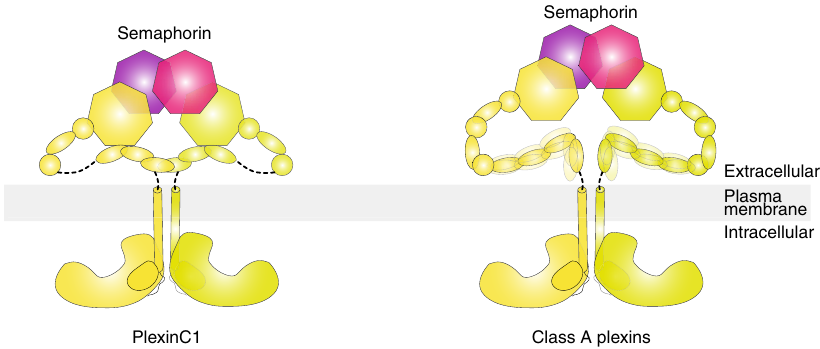
Fig. 6 Cartoon models of the active complexes of PlexinC1 and class A plexins. The models highlight the different architecture between PlexinC1 and class A plexins. The conformation of the membrane-proximal IPT2 – 4 domains in PlexinC1 is stable due to their tight interactions with the Sema domain. In contrast, previous crystallographic studies have suggested that the conformation of the membrane-proximal domains in class A plexins show substantial variations (indicated by the blurring effect). Structures of full-length class A plexins in complex with semaphorin are not available. The model of class A plexins is constructed by combining the structures of the apo state intact PlexinA ectodomains and the structures of the N-terminal ligand-binding domain of PlexinA in complex